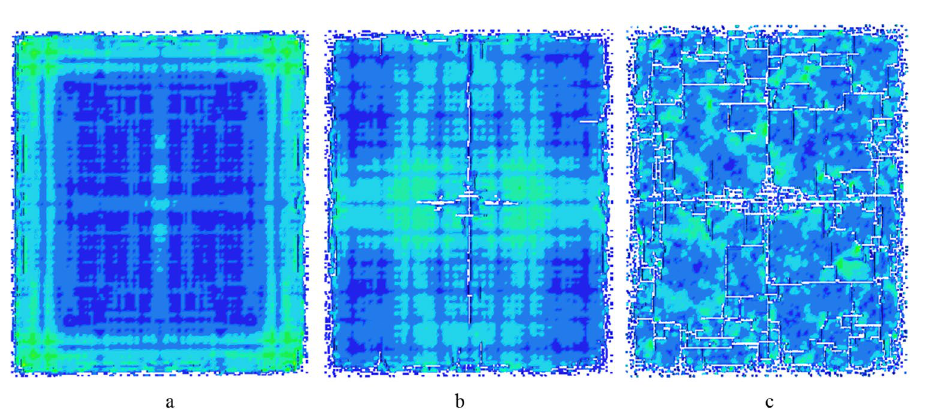
Figure 10. The dynamic damage and failure process of single-layered thin plate rock